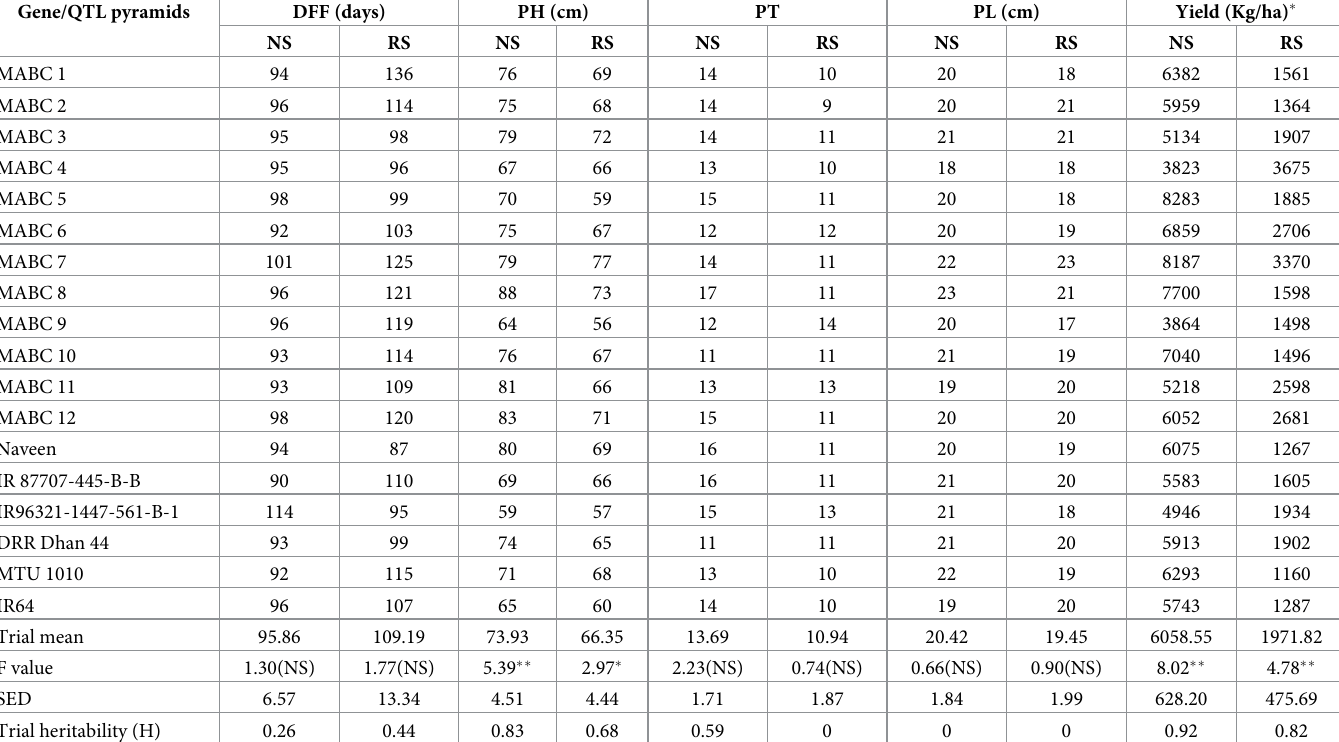
Table 4. Agronomic and yield performance of selected pyramided lines developed through the MABC approach. Gene/QTL